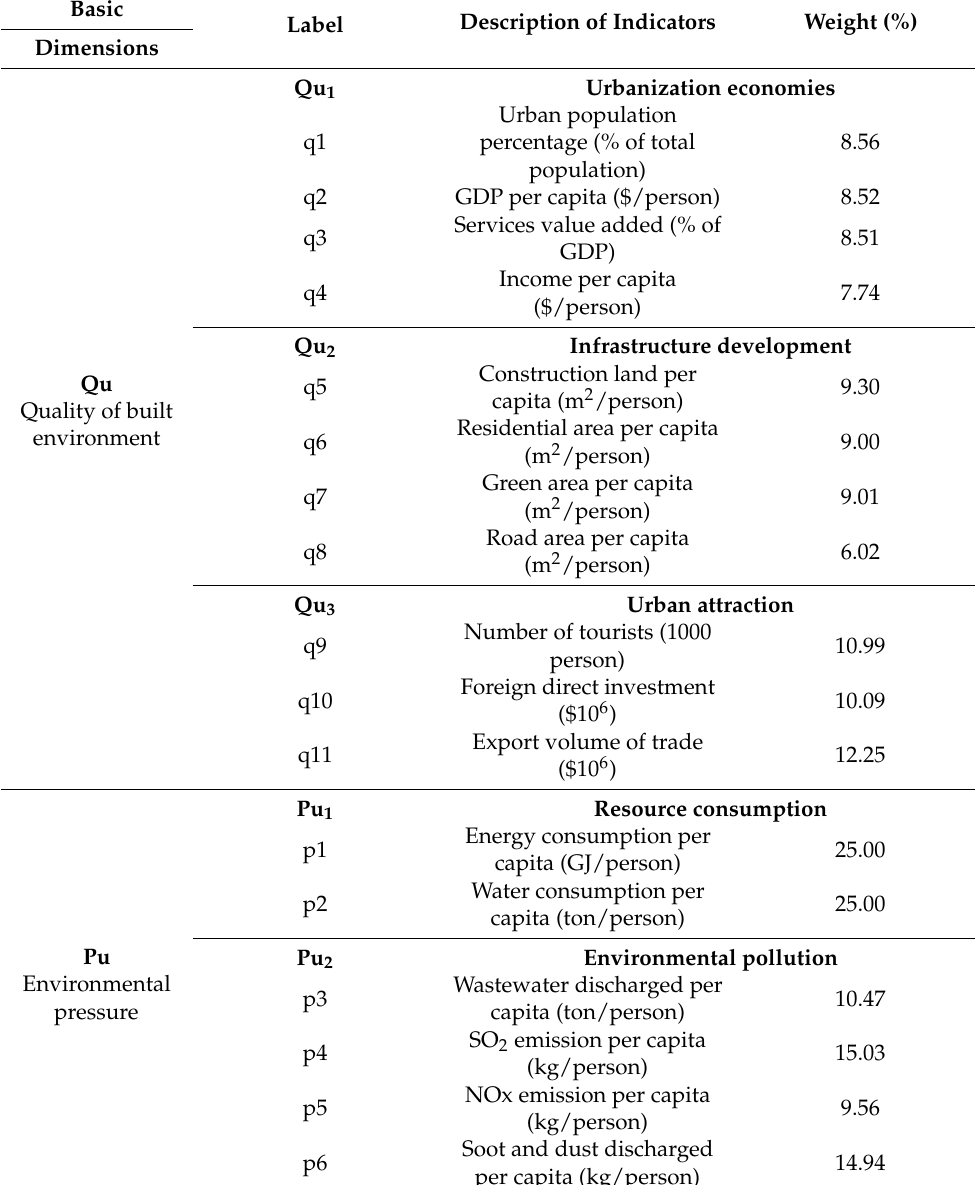
Table 2. List of indicators and their